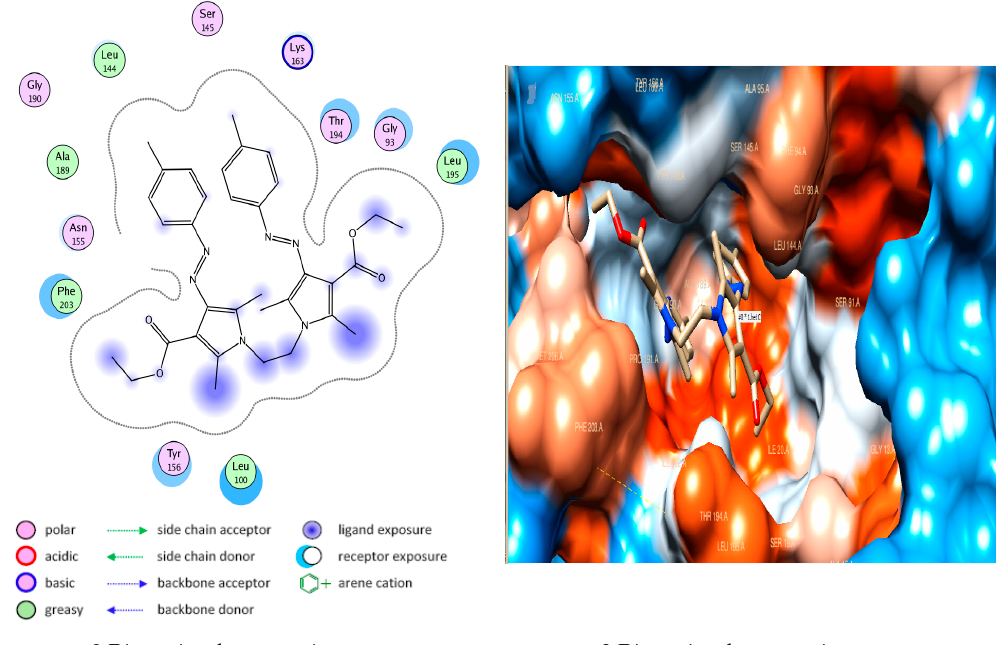
Figure 2. Docking of compound 5b into E. coli Enoyl reductase Enzyme (PDB ID: 1LXC).